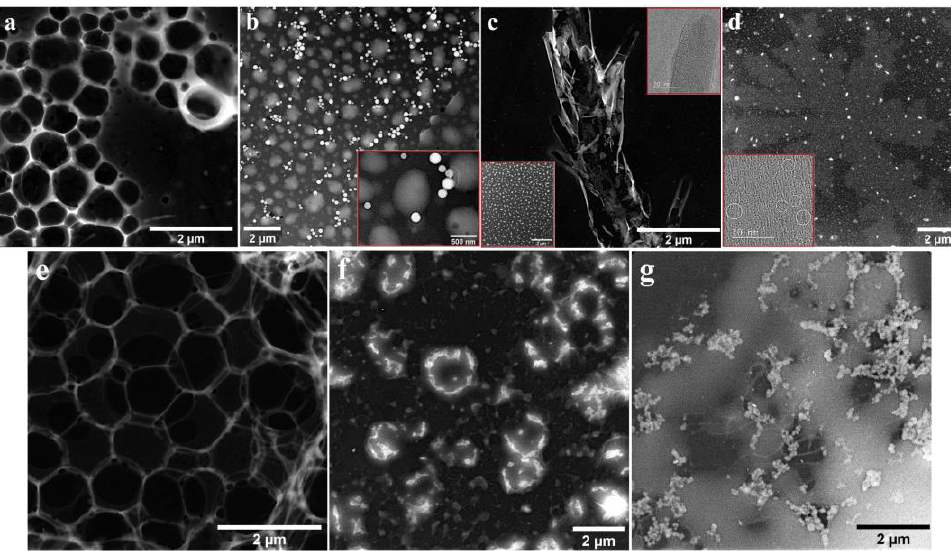
Figure 1. TEM/STEM images recorded for the P1 and P2 porphyrins, drop-casted on TEM grids from solutions obtained using different solvents. The insets present HR-TEM images.